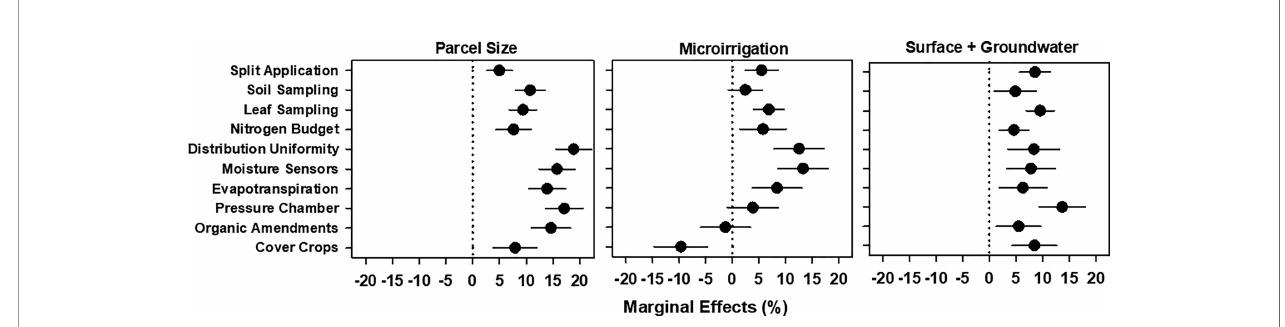
FIGURE 3 | Marginal effects for conservation practices for nitrogen (N) management with standard errors from regression models are shown for variables of parcel size, irrigation system and water source. Effects are parcel sizes >20 ha relative to baseline parcel sizes ≤ 20 ha; use of microirrigation relative to a baseline of surface irrigation; and access to surface and groundwater sources relative to groundwater only.